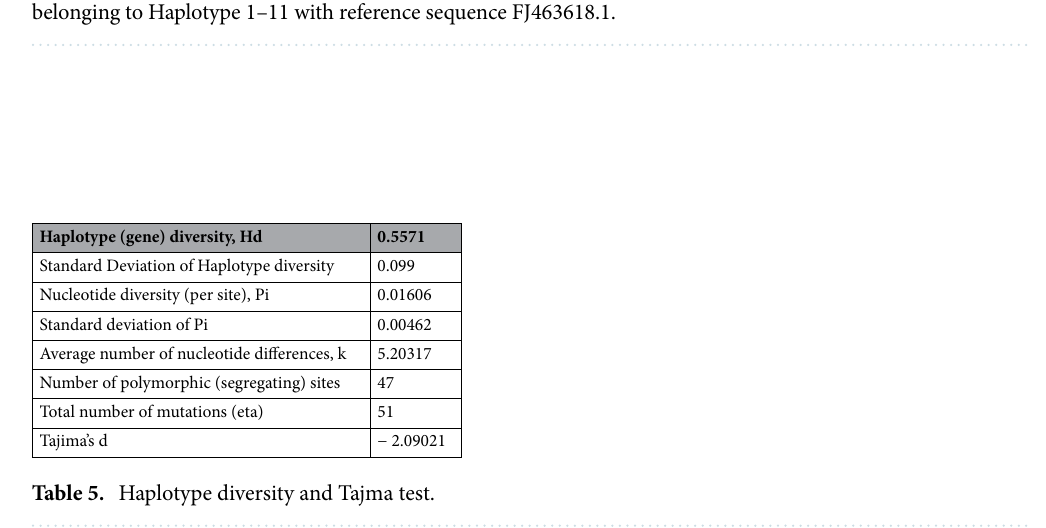
Figure 5. Sequence alignment of MLO gene (906–1229 bp) of powdery mildew resistant pea accessions belonging to Haplotype 1–11 with reference sequence FJ463618.1.